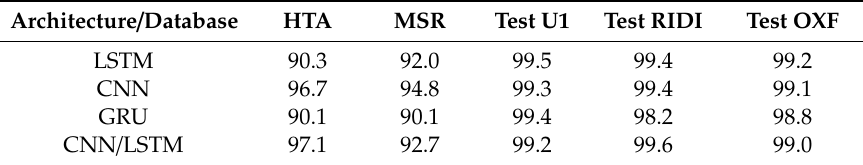
Table 8. Test accuracy results when training on the TrainROU dataset while using both accelerometer and gyroscope measurements.